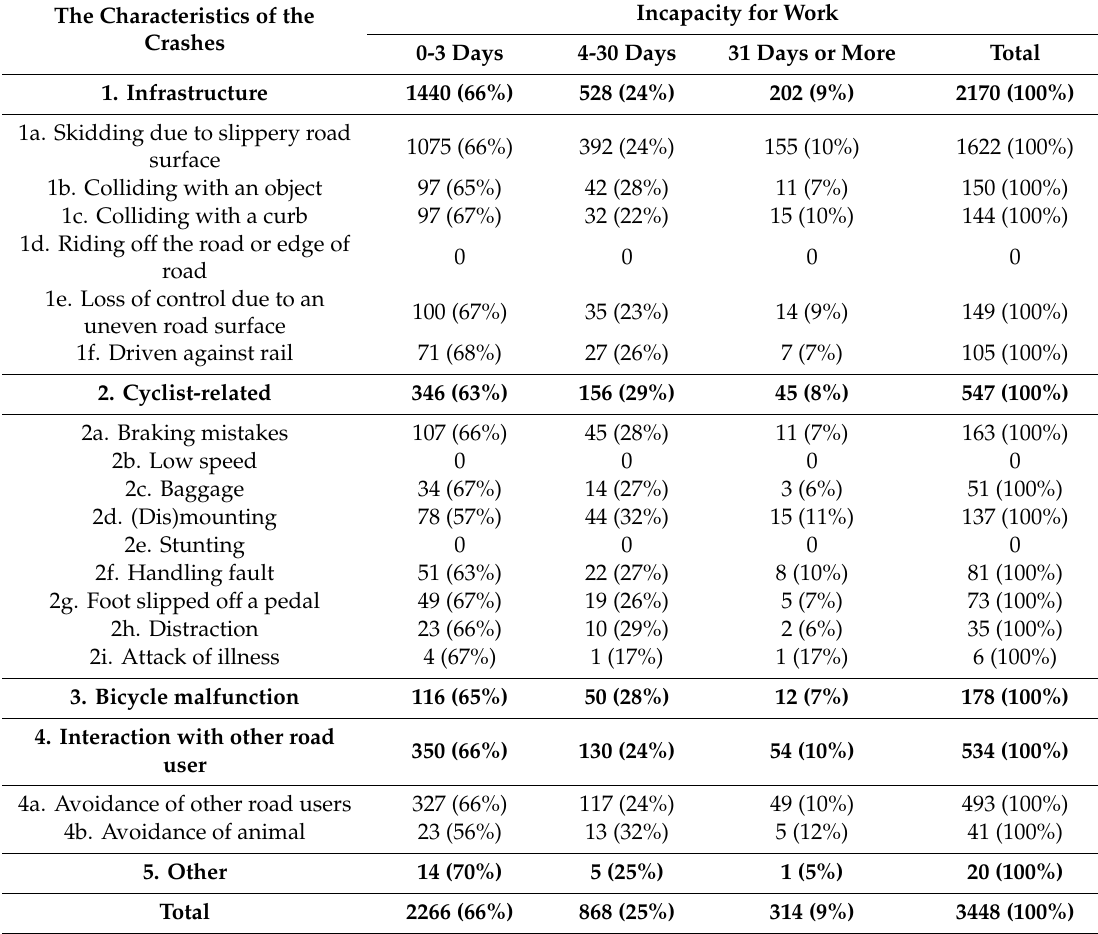
Table A2. The amount of days of incapacity for work and the characteristics of the